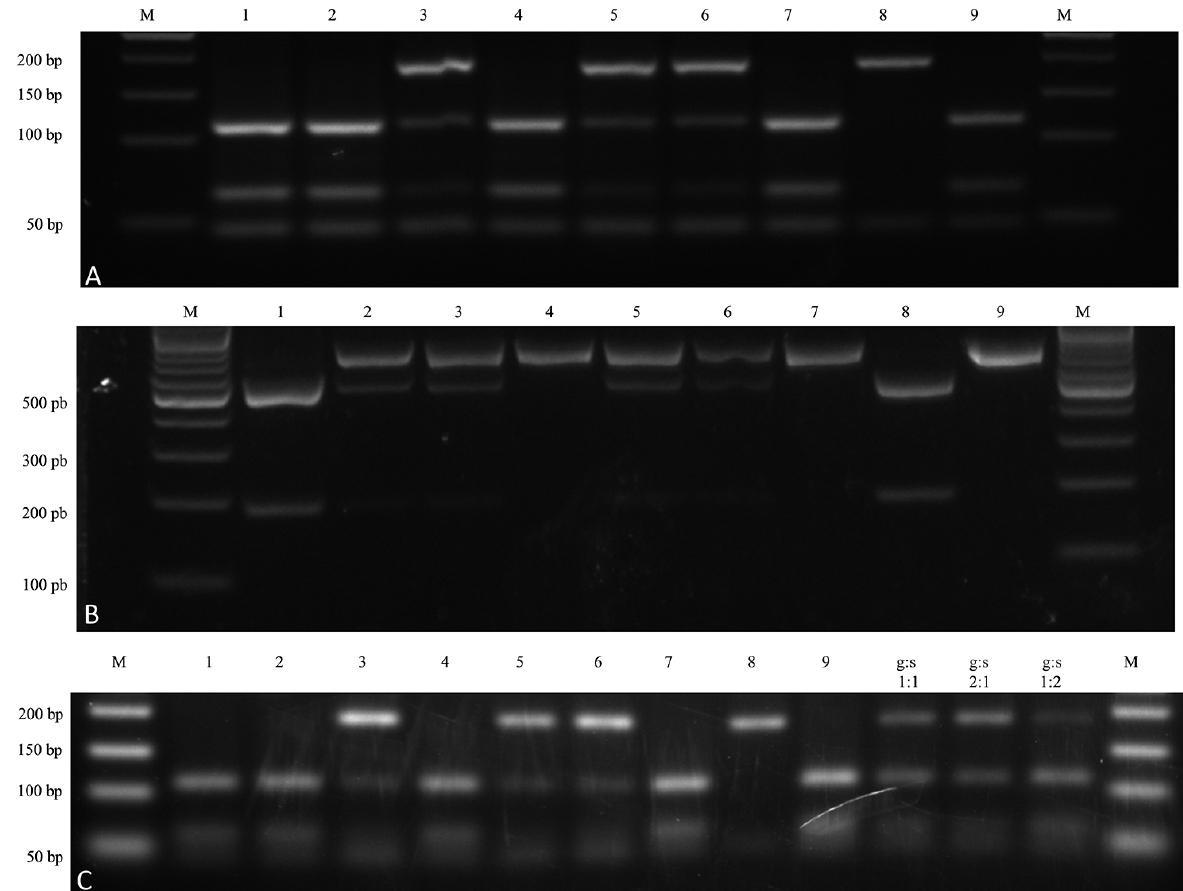
Figure 1 – Electrophoresis gel fractionated products on agarose stained with GelRed showing homozygous and heterozygous PCR-RFLP patters. A: hsp 70 PCR-RFLP ( Hae III). M: 50 bp molecular weight marker (Fermentas SM 0373). Lanes 1 to 7: isolates 1 to 7, respectively. Lane 8: L. (V.) guyanensis (MHOM/BR/1975/M4147). Lane 9: L. (V.) shaw shawi (MCEB/BR/1984/M8408). B: mpi PCR-RFLP ( Cla I). M: 100 bp molecular weight marker (Fermentas SM 0331). Lanes 1 to 7: isolates 1 to 7, respectively. Lane 8: L. (V.) guyanensis (MHOM/BR/1975/M4147). Lane 9: L. (V.) shaw shawi (MCEB/BR/1984/M8408). C: SNP-CAPS hsp70 PCR-RFLP ( Hae III). All lanes contain 300 ng of purified PCR products digested by Hae III. Lanes 1 to 7: hybrids Leishmania ( Viannia ) spp. isolates 1 to 7, respectively. Lane 8: L. (V.) guyanensis ; Lane 9: L. (V.) shawi shawi; Lane 10: L. (V.) guyanensis : L. (V.) shawi shawi (1:1); Lane 11: L. (V.) guyanensis : L. (V.) shawi shawi (2:1); Lane 12: L. (V.) guyanensis : L. (V.) shawi shawi (1:2); and M: 50 bp molecular weight